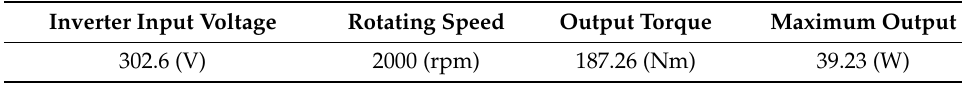
Figure 25. Current test waveforms for the final model: ( a ) current waveform when it was operating the motor at maximum output; ( b ) current waveform when it was operating the motor at maximum efficiency. Table 5. Maximum efficiency test result. Table 4. Maximum output test result of the final model.